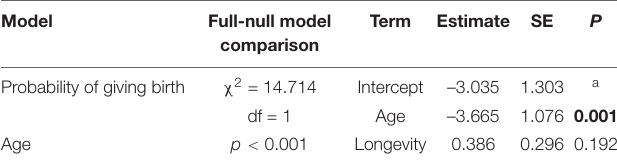
TABLE 6 | Results of the models in captive red lemurs on the probability to give